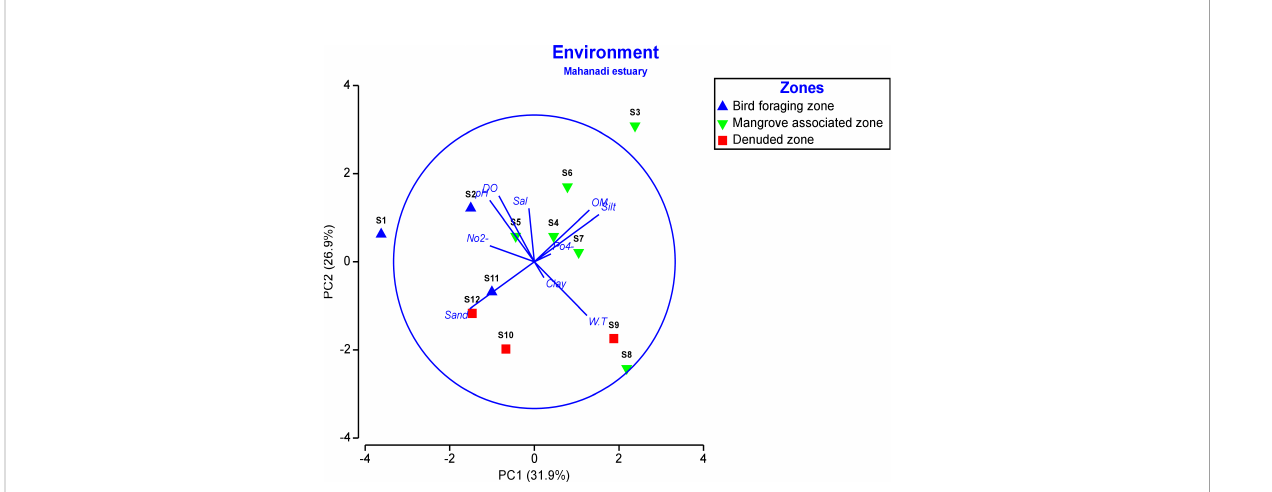
FIGURE 3 Principal Component Analysis (PCA) depicting the in fl uence of environmental variables on the sampling (1-12) sites of the Mahanadi estuary during 2013-2017.The circle represents the correlation circle, and the orientation of the environmental parameters (lines) approximate their correlation to each other and to the ordination axes (DO = dissolved oxygen, Sal = salinity, OM = total organic matter, NO (cid:1) 2 = nitrite-nitrogen, PO4 - = orthophosphate, WT = water temperature). The MAZ (n = 66) – Mangrove associated zone includes St. 3, 4, 5, 6, 7, and 8, The BFZ (n = 33) – Birds foraging zone includes St. 1, 2 and 11, and the DZ (n = 33) – Denuded zone is represented by St. 9, 10 and